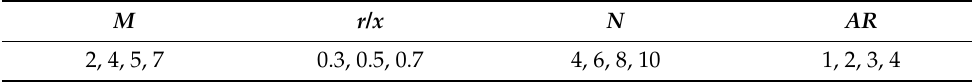
Table 3. Fixed shape variables for SIF sensitivity analyses.